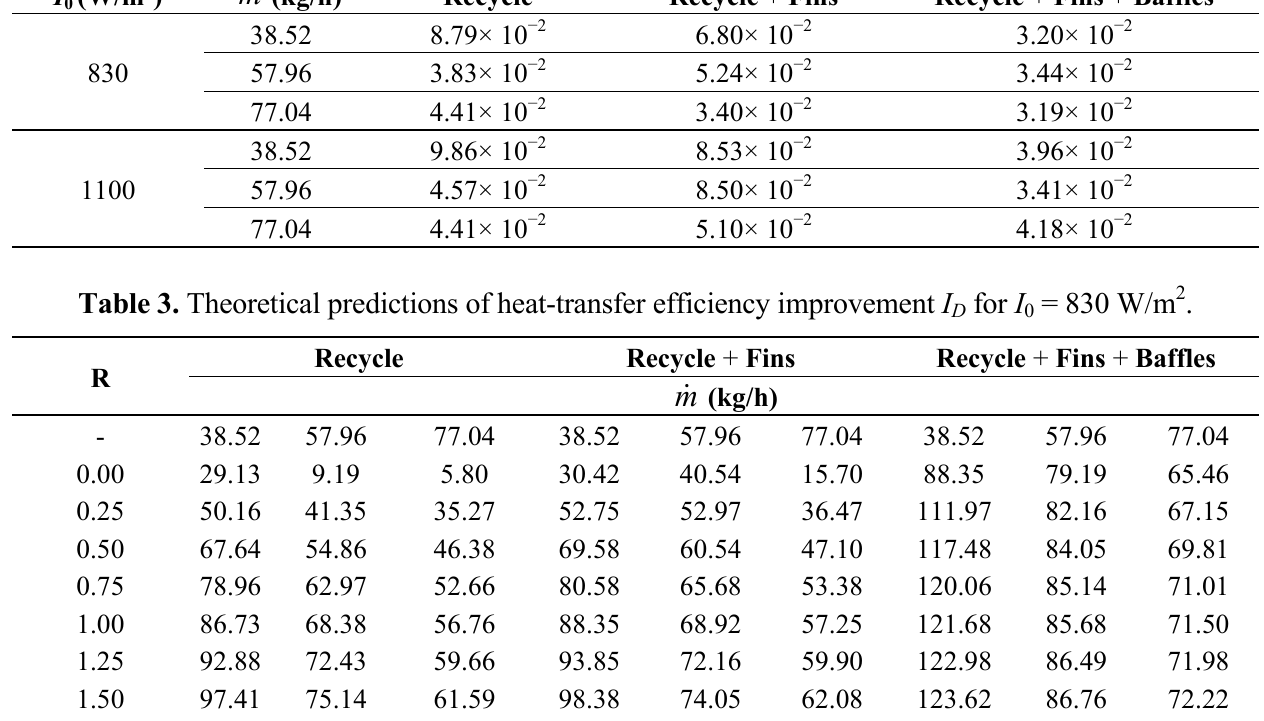
Table 2. The accuracy analysis of the experimental results.